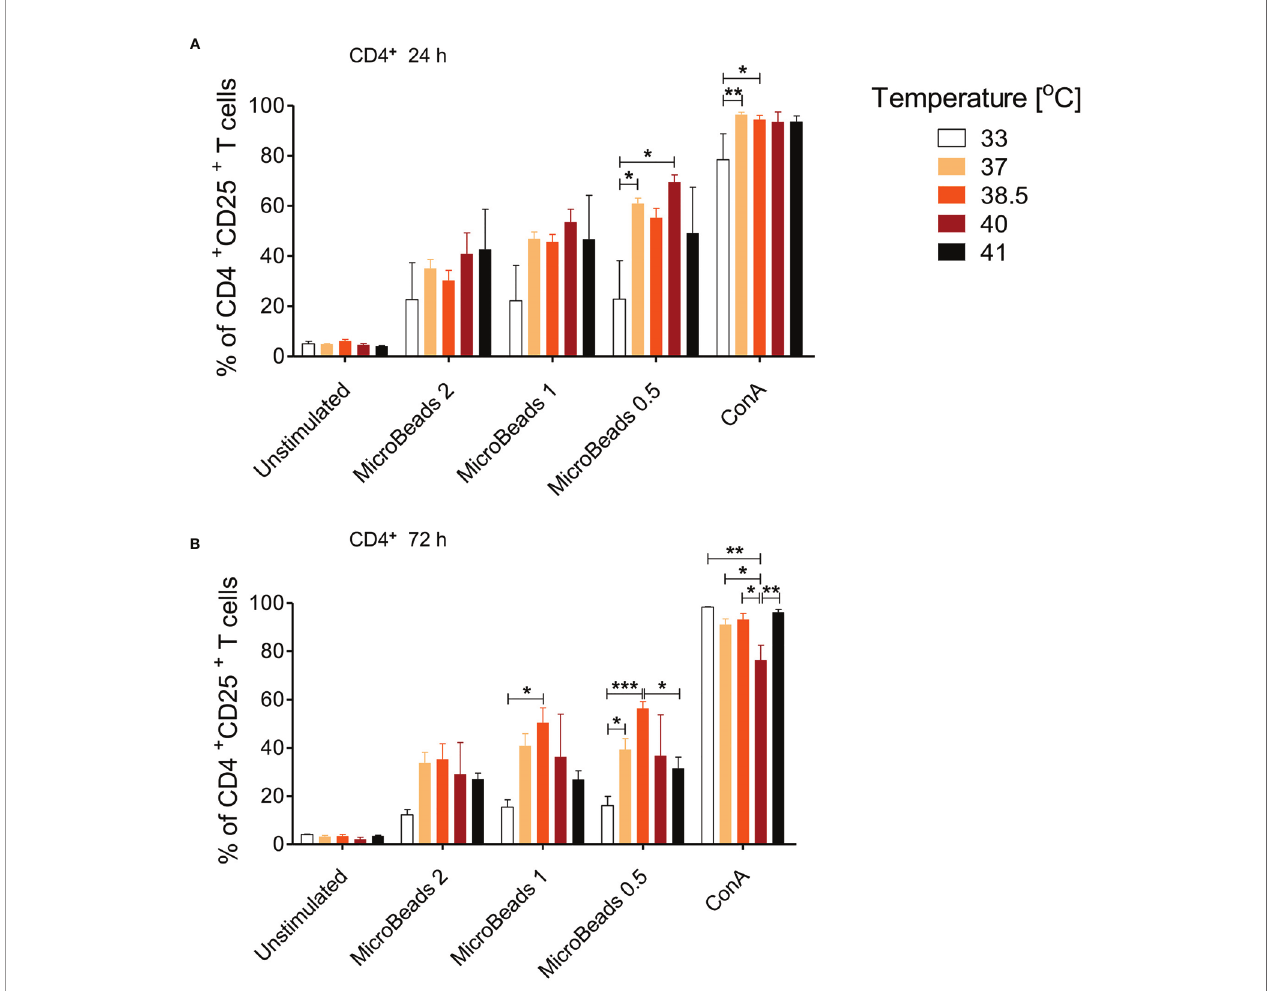
FIGURE 5 | The effect of culture temperature on activation of canine CD4 + T lymphocytes. Quanti fi cation of activated CD4 + CD25 + T lymphocytes after 24 h (A) and 72 h (B) post stimulation using different MicroBeads concentrations (as indicated) and ConA. To assess the impact of temperature PBLs were incubated in 33°C, 37°C, 38.5°C, 40°C or 41°C in humidi fi ed incubator, 5% CO2 (Sanyo Electric). Data are shown as the mean of fi ve dogs (n=5), and error bars indicate SEM. Statistical analysis was performed by One-way analysis of variance (ANOVA) with Tukey ’ s Multiple Comparison Test (*p < 0.05 ,**p < 0.01, ***p <